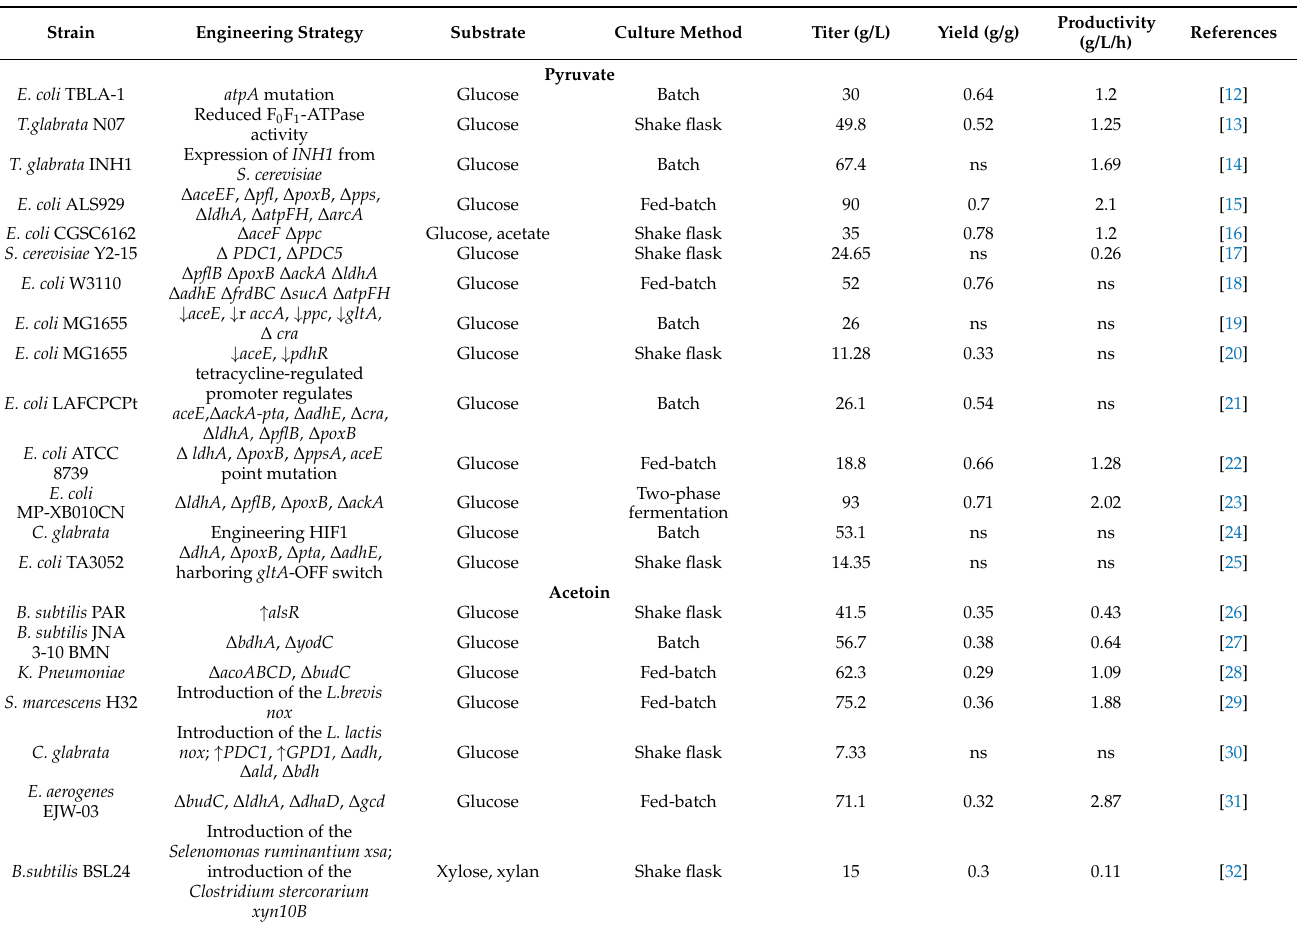
Table 1. Effects of different metabolic engineering strategies on